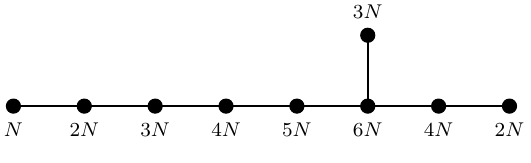
Figure 1 . 4d SU -type N = 2 gauge-theory quiver for the rank-N E 8 theory. The same quiver graph describes the ‘electric quiver’ EQ (4) , seen as a 3d N = 4